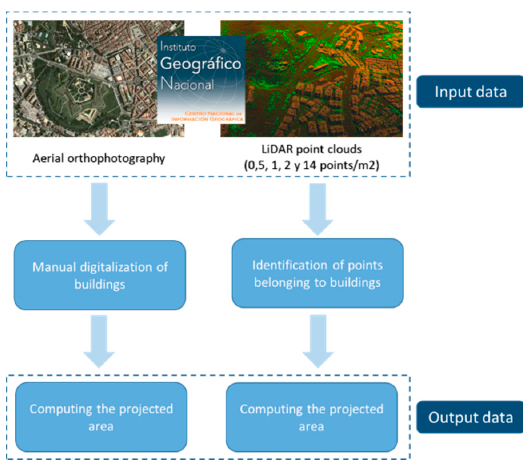
Figure 2. Workflow of the methodology followed to evaluate the influence of the density.